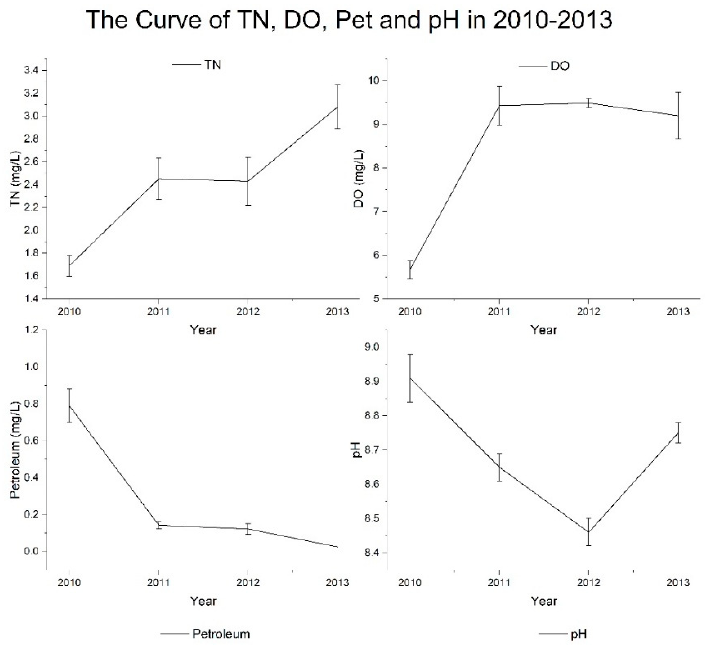
Figure 3. The average concentration curves of the indices total nitrogen (TN), dissolved oxygen (DO), petroleum (Pet) and pH between 2010 and 2013.